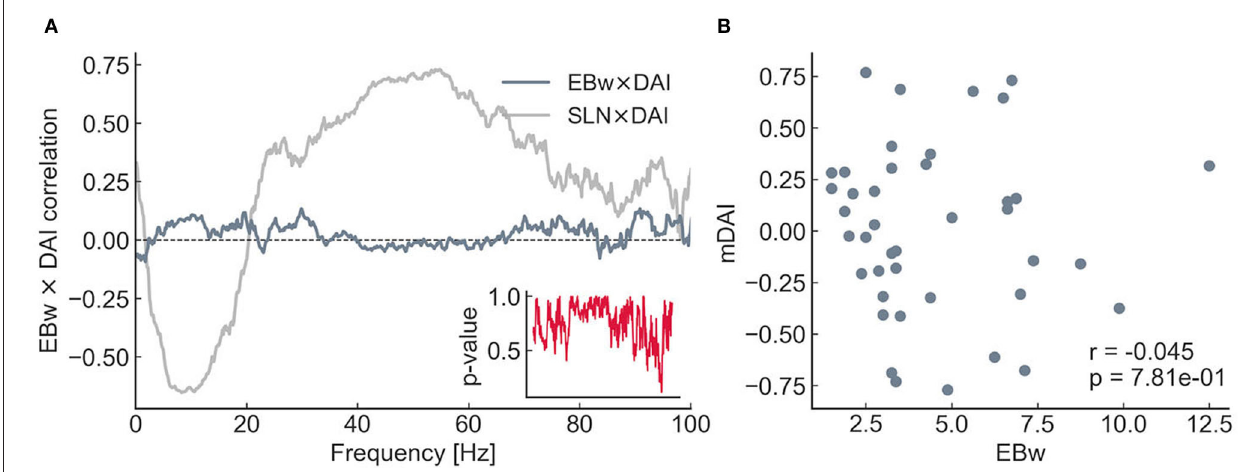
FIGURE 7 | Relationship between the DAI and the edge betweenness (EBw with α and k ) for the 8 × 8 subgraph. The layout is the same as for Figures 6C,D . In contrast with the CD, no significant correlations can be seen either with the DAI (A) or with the mDAI (B)